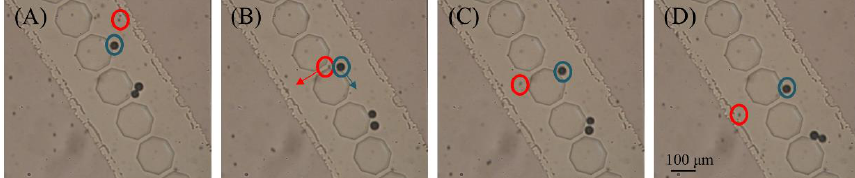
Figure 4. Simulation results of the influence of the inclination angle of the microfilter array on the collection efficiency: ( A ) Y* (the normalized displacement of y direction); ( B ) Fy* (the normalized y-component of the total force acting on the particle); and ( C ) electric field and flow field when α = 75°.